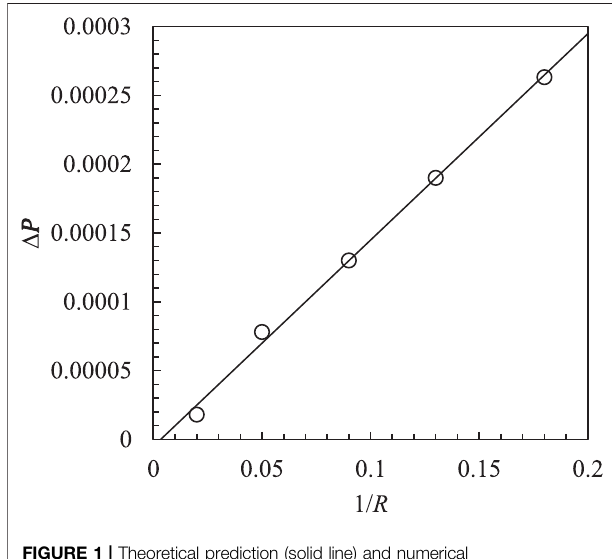
FIGURE 1 | Theoretical prediction (solid line) and numerical measurements of Laplace law (circles).